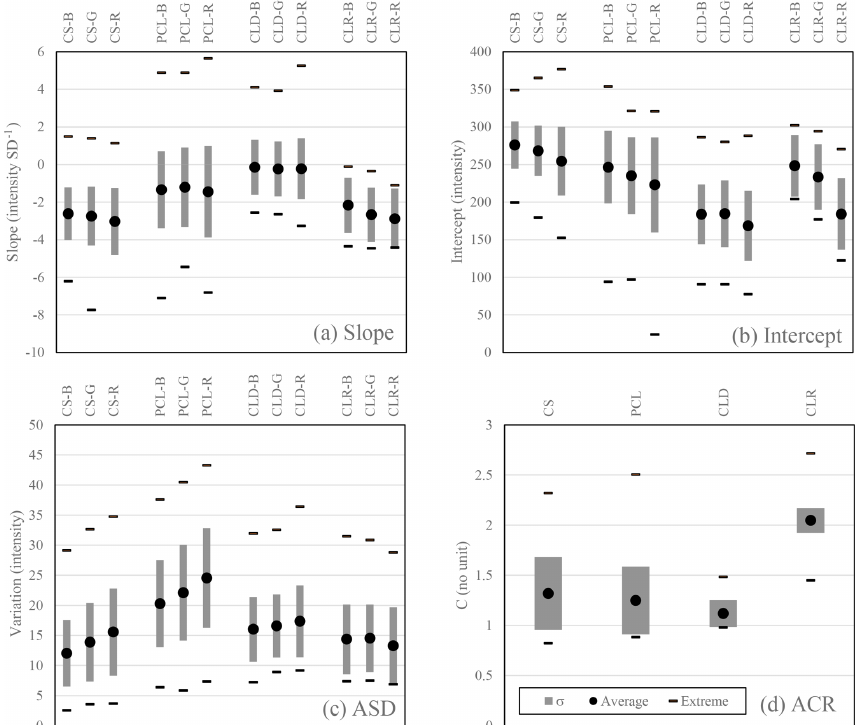
Figure 5. Photographic sky type properties. Slope and intercept (a, b) for the radial fit; areal standard deviation (ASD) of brightness (c) ; average color ratio (ACR) (d) . Sky types were assigned visually.